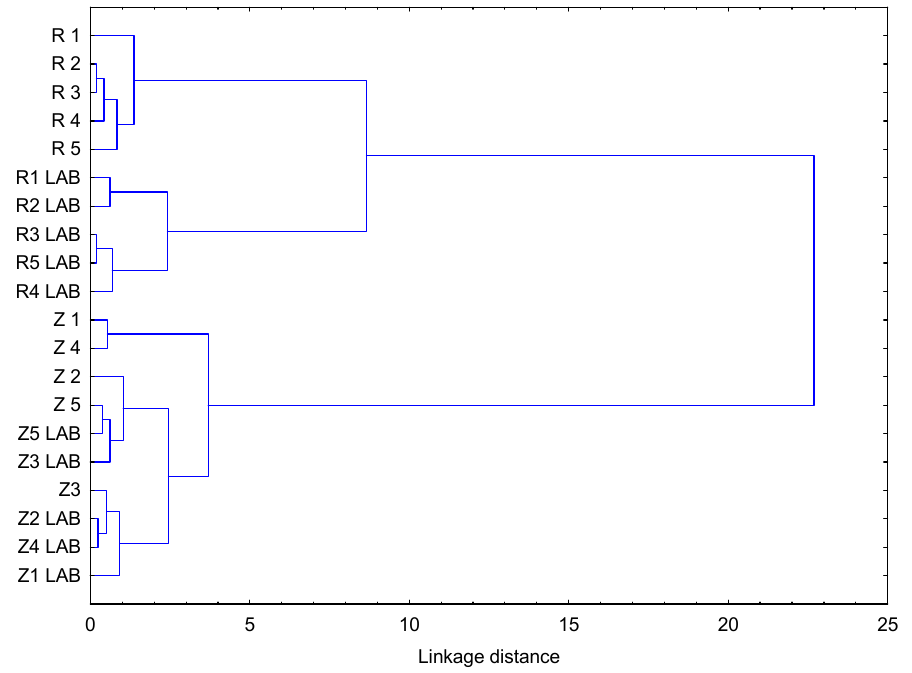
Figure 6 . Dendrogram showing clustering of wines made of Zweigelt and Rondo varieties (R1-R5-wines from the Rondo variety, in which alcoholic fermentation was carried out by different yeast strains and malolactic fermentation was spontaneous; R1 LAB–R5 LAB—wines from the Rondo variety, in which alcoholic fermentation was carried out by different yeast strains (but the same as in R1–R5 wines), and malolactic fermentation was induced; Z1-Z5-wines from the Zweigelt variety, in which alcoholic fermentation was carried out by different yeast strains and malolactic fermentation was spontaneous; Z1 LAB–Z5 LAB-wines from the Zweigelt variety, in which alcoholic fermentation was carried out by different yeast strains (but the same as in Z1–Z5 wines), and malolactic fermentation was induced) .